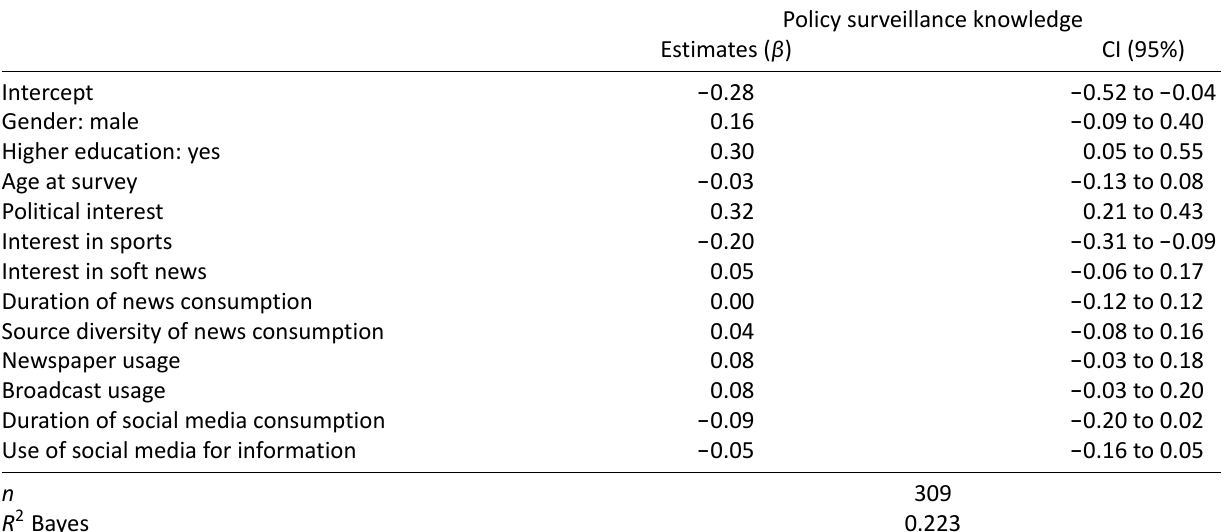
Table 2. Regression model for policy surveillance